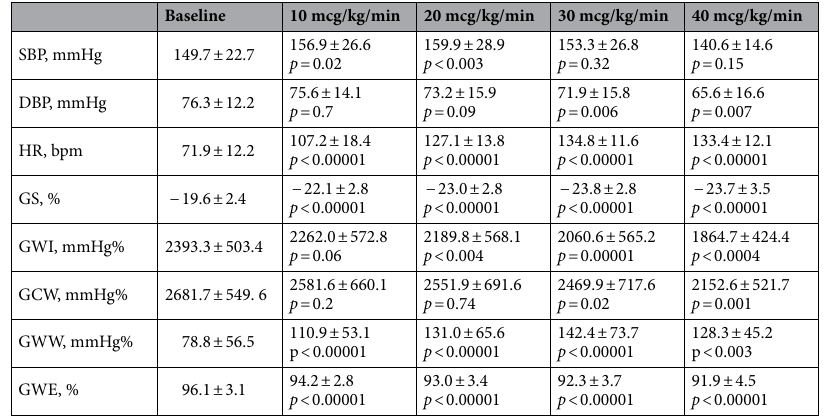
Table 2. Myocardial work index parameters during normal dobutamine stress echocardiography.